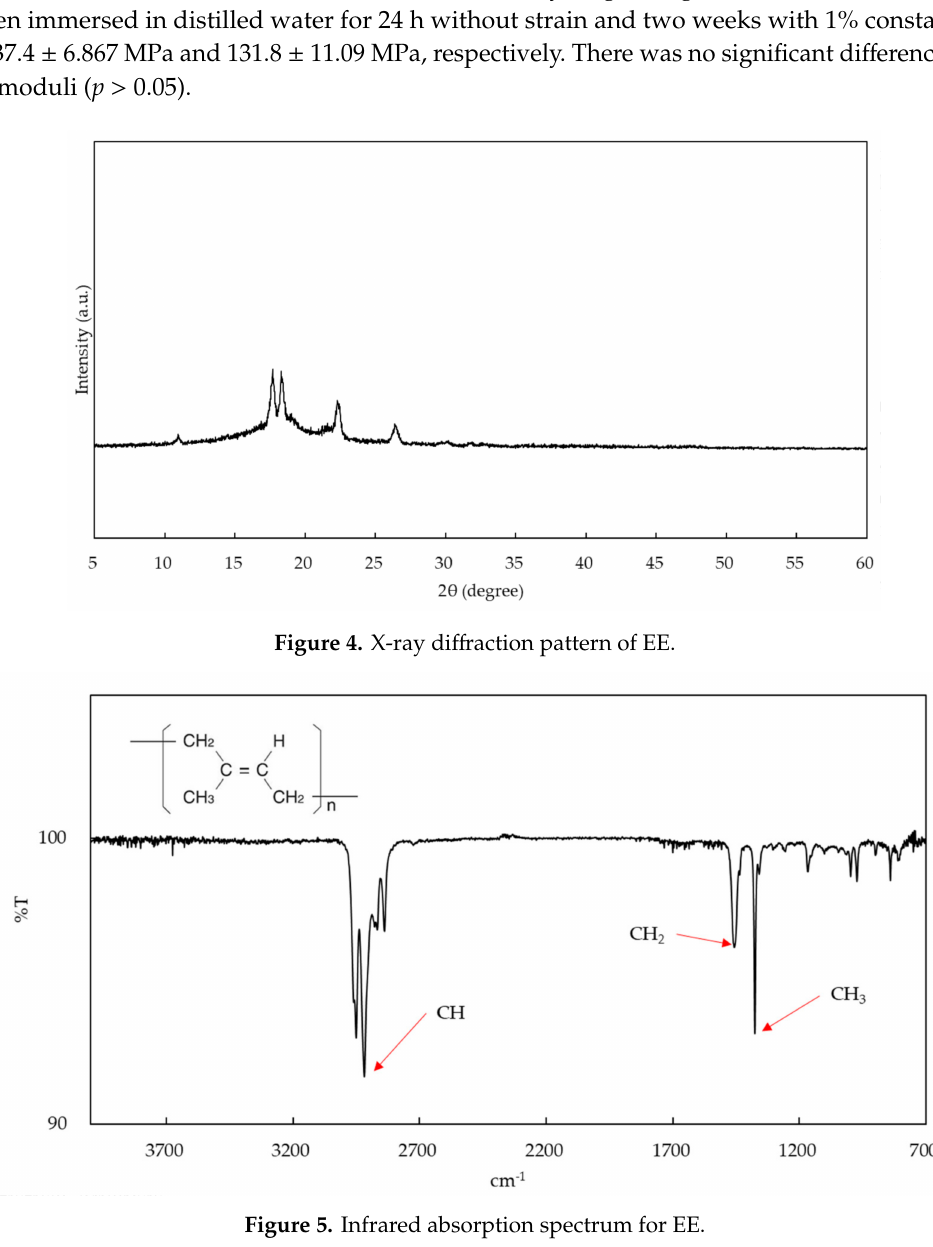
Figure 5. Infrared absorption spectrum for